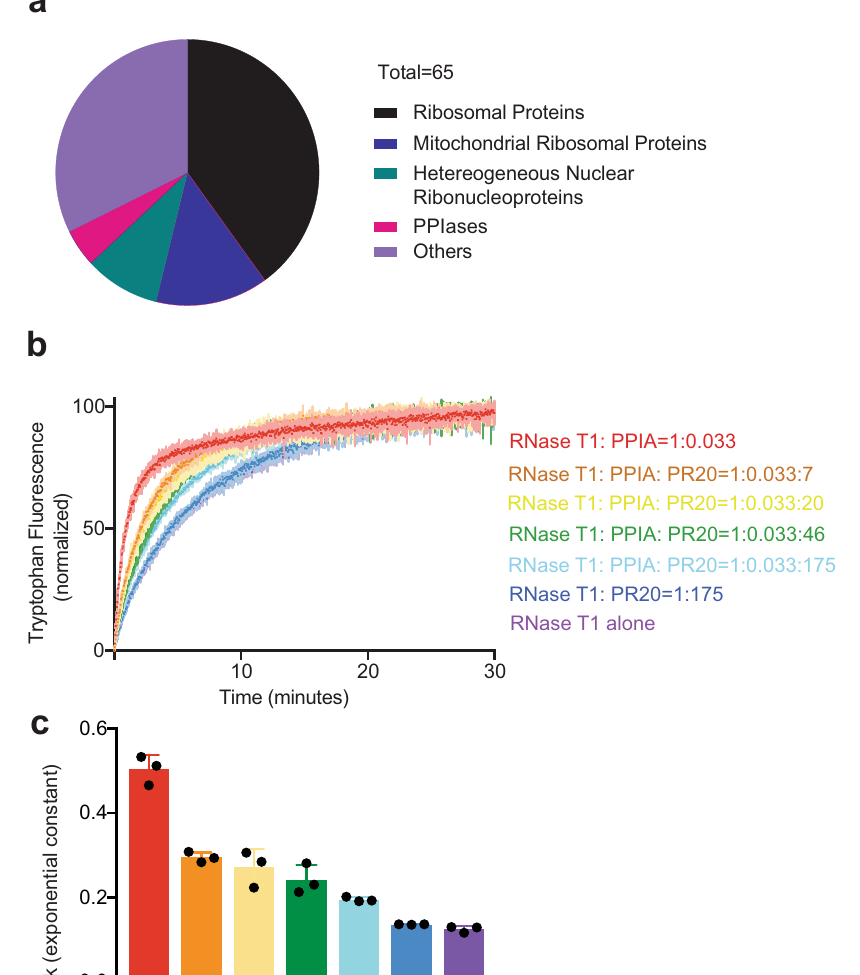
polymers of decreasing repeat number. Repeat polymers with ten (PR10) and fi ve (PR5) PR dipeptides ef fi ciently bound to PPIA (Supplementary Fig. 2a). For PR10 we determined the dissocia- tion constant 27 ± 5 µM (Fig. 2e), i.e. slightly lower than the PR20 af fi nity. In the case of PR5, the K d value further decreased to 49 ± 16 µM (Fig. 2e). Additional shortening of the peptide chain to two PR dipeptides abrogated the binding to PPIA: even an eightfold excess of PR2 did not in fl uence the enzyme ’ s NMR signals (Supplementary Fig. 2a).